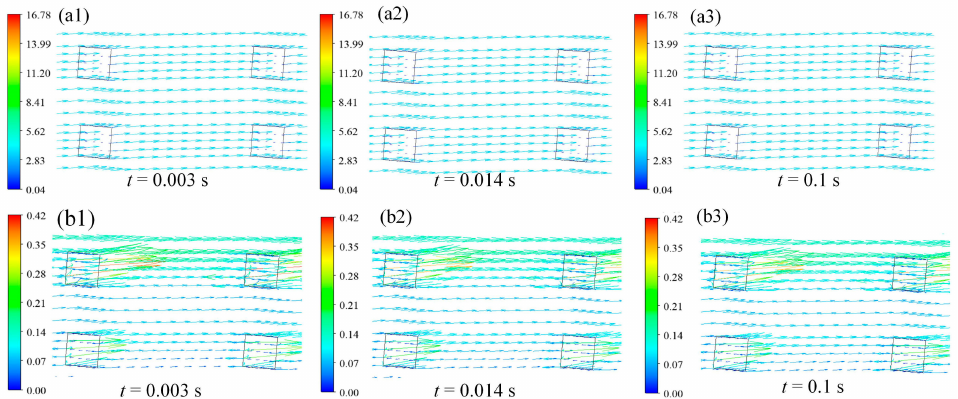
Figure 21. Vector diagram of local oil flow velocity in oil films with different times (( a1 ) is velocity vectors of oil when t = 0.003 s; ( a2 ) is velocity vectors of oil when t = 0.014 s; ( a3 ) is velocity vectors of oil when t = 0.1 s; ( b1 ) is velocity vectors of vapor when t = 0.003 s; ( b2 ) is velocity vectors of vapor when t = 0.014 s; ( b3 ) is velocity vectors of vapor when t = 0.1 s).